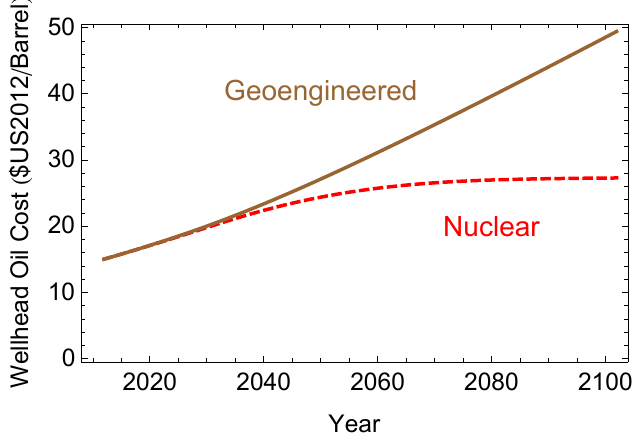
Figure 6. Oil wellhead cost with nuclear-led decarbonization (solid curve), versus a geoengineeered outcome with stratospheric sulfur injection along with subsequent extensive carbon sequestration (solid